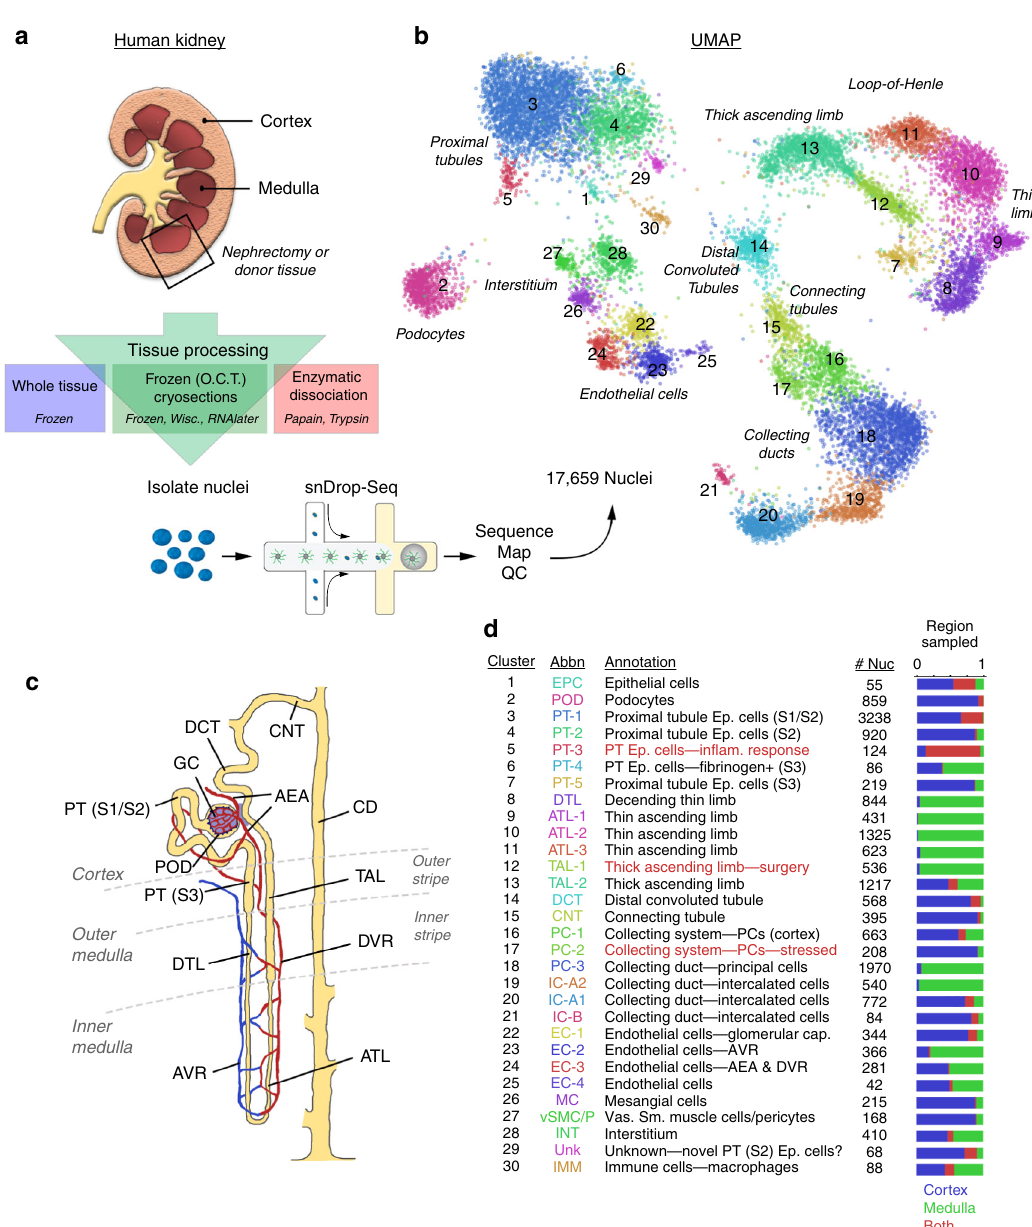
Fig. 1 Single-nucleus RNA-seq interrogation of the human kidney. a Overview of kidney tissue processing methods tested for nuclei isolation and snDrop- seq. b UMAP visualization of 17,659 single nuclei (15 individuals, Supplementary Data 4) passing QC fi ltering (Supplementary Fig. 2a). Source data are provided as a Source Data fi le. c Schematic of a juxtamedullary nephron 36 showing relevant cell types and associated vasculature. d Table of single-nucleus clusters shown in ( b ), indicating associated cell-type annotations, number of nuclei per cluster and relative origination from samples encompassing the cortex, medulla or both (Supplementary Data 6 and provided as a Source Data File). UMAP uniform manifold approximation and